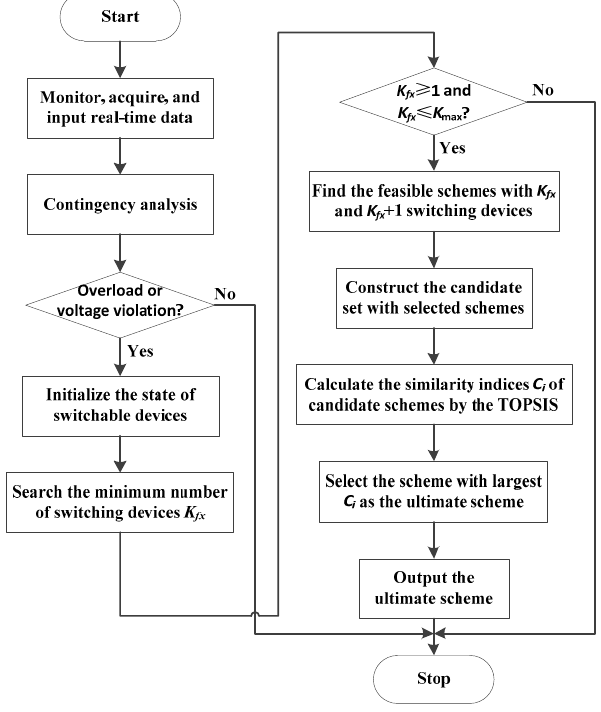
Figure 1. The flowchart of proposed two-phase optimization approach.